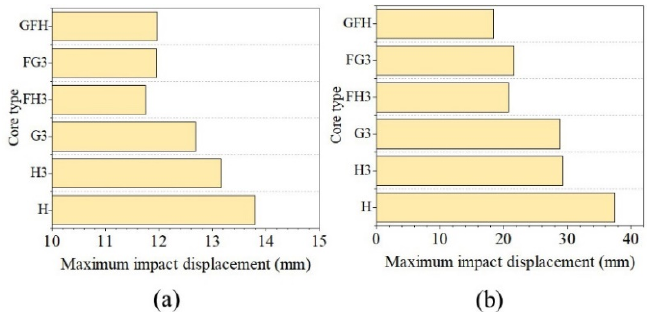
Figure 21. Maximum impact displacement of various panels with hemisphere impactor. ( a ) Impact energy at 50 J. ( b ) Impact energy at 100 J.